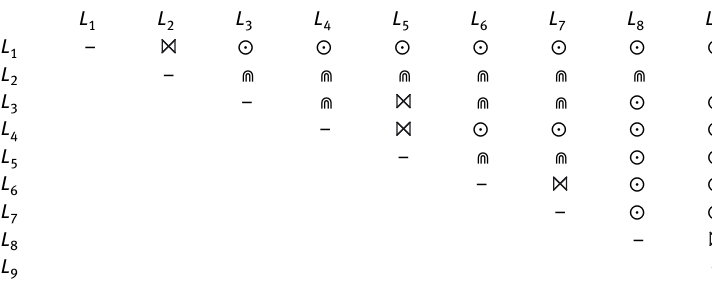
Table 6: Relation matrix of the core, illustrated in Figure 9A, of the